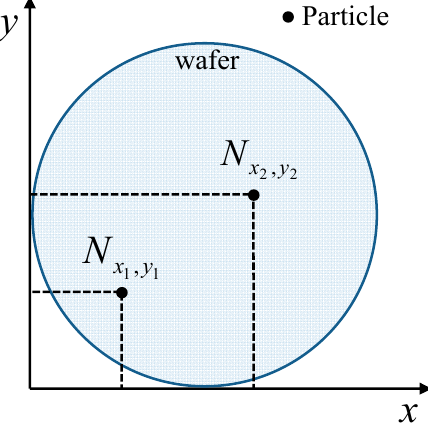
Figure 5. Particle measurements on a test wafer.